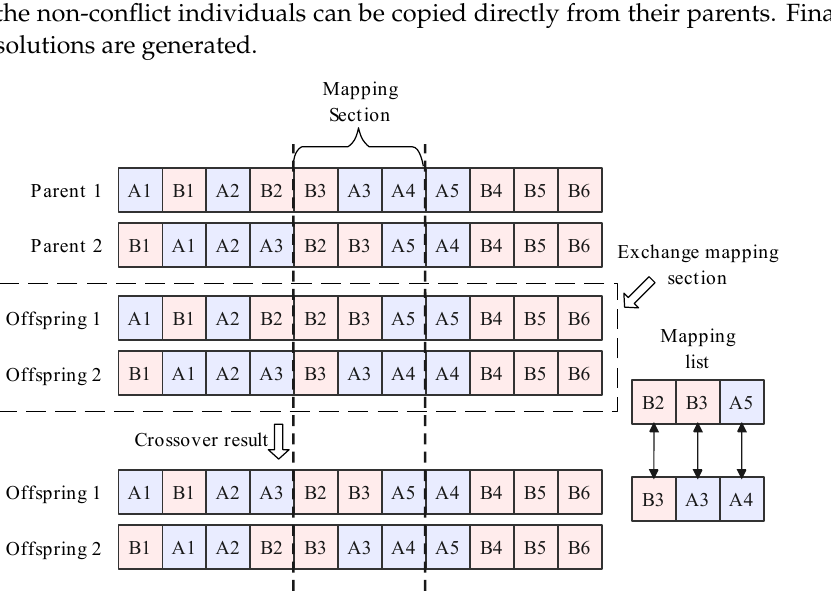
Figure 4. Operation process of the partial mapped crossover.